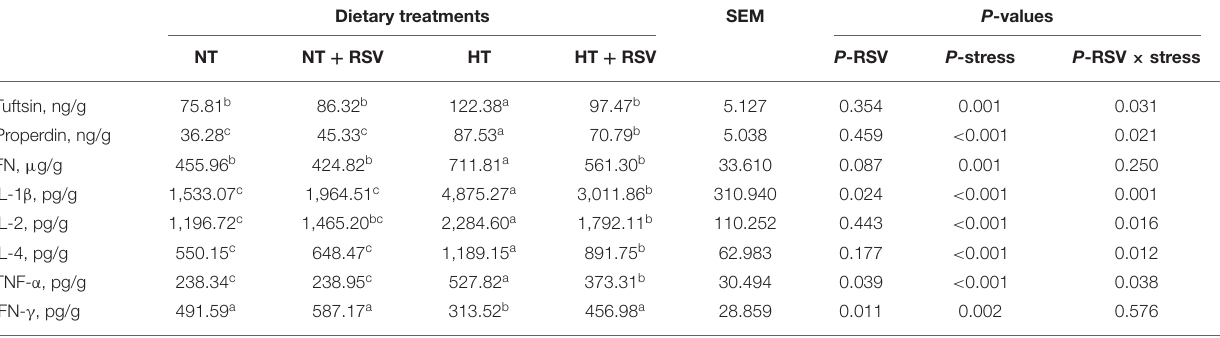
TABLE 7 | Effect of heat stress and RSV on the levels of cytokines in spleen of 42-day-old broilers (d 14 of heat treatment). Dietary treatments SEM P -values NT NT + RSV HT HT + RSV P -RSV P -stress P -RSV × stress